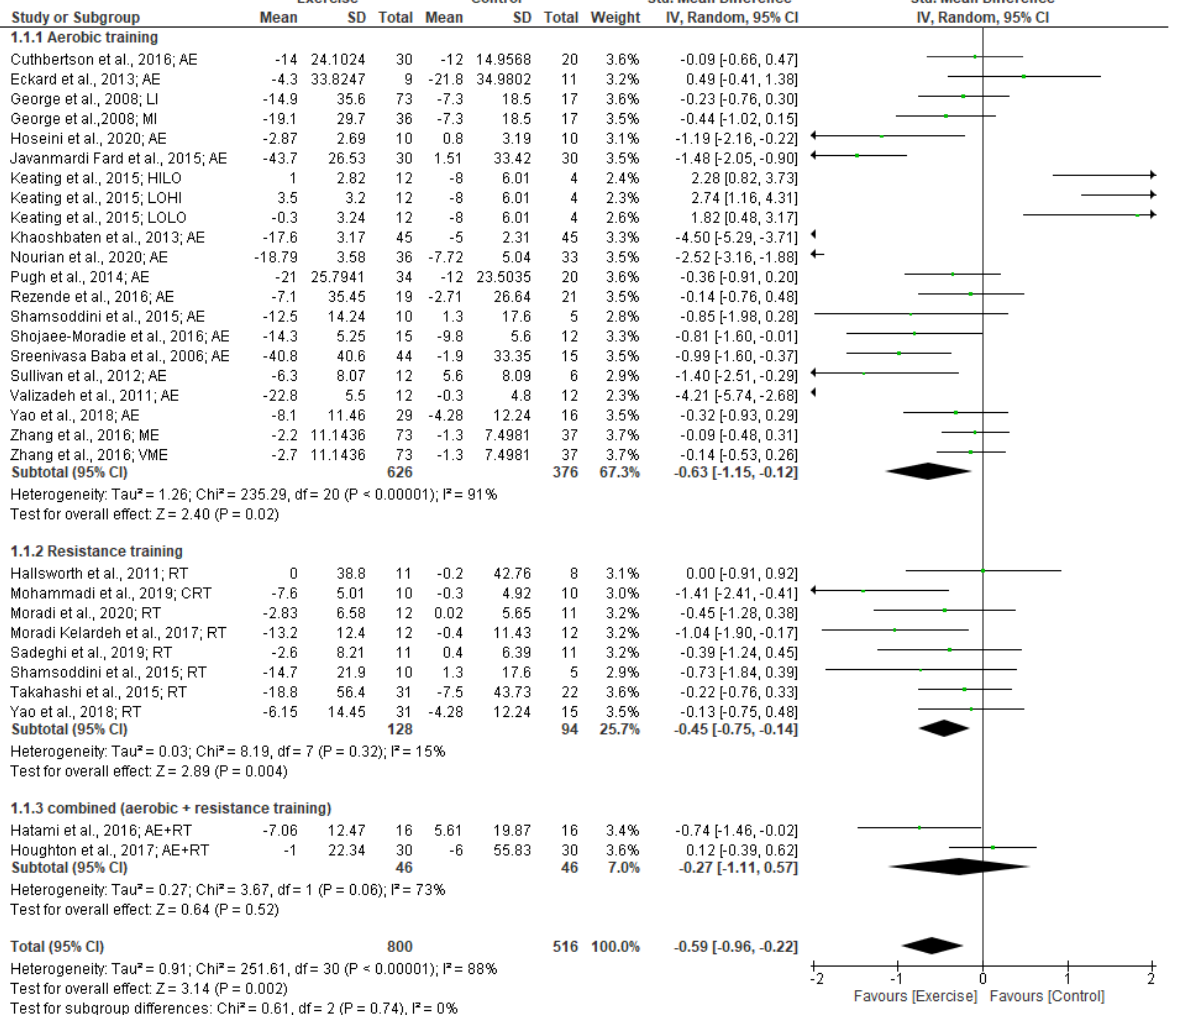
Figure 2. Forest plot showing study precision against the mean difference effect estimate with 95% confidence interval for ALT [28–52].